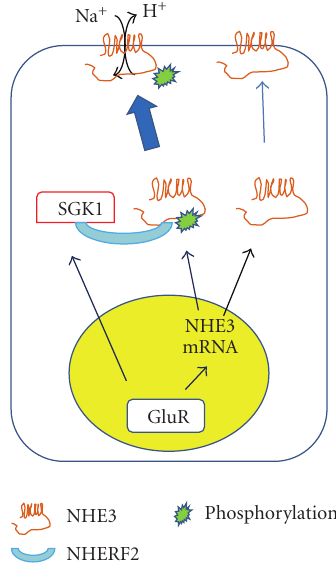
Figure 3: Activation of NHE3 by glucocorticoids. Glucocorticoids stimulate NHE3 mRNA and protein expression. This stimulation results in an increase in NHE3 protein expression at the apical membrane. In addition, sca ff olding of SGK1 by NHERF2 allows phosphorylation of NHE3. The phosphorylation of NHE3 by SGK1 facilitates sorting of NHE3 to the apical